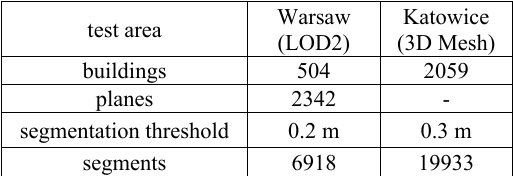
Figure 1. Workflow of the proposed method of building quality Table 1. General segmentation statistics for both test assessment (yellow - parts unique for CityGML models, green - parts unique for 3D meshes, blue - parts common for both types of building models)